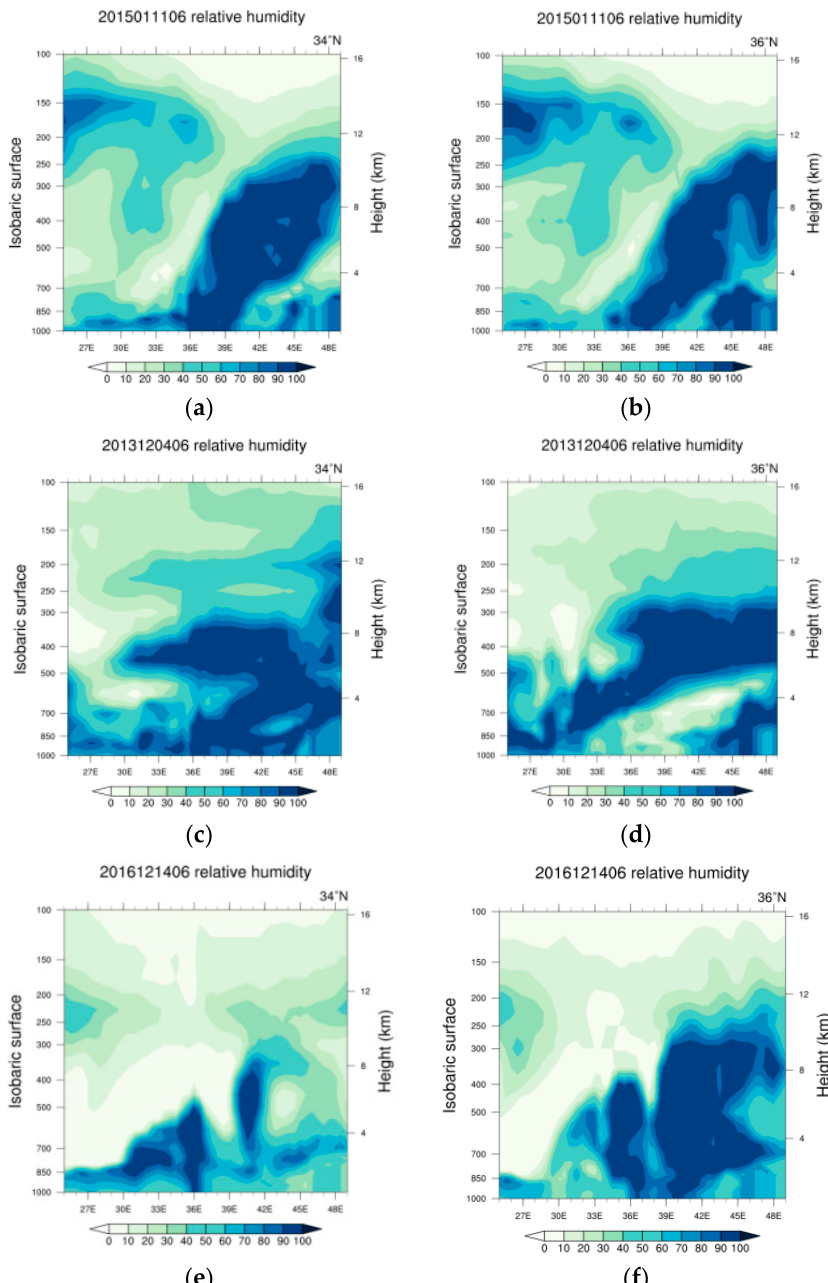
Figure 6. Vertical cross-section of relative humidity (unit: %) along 36° N and 34° N on strong rainfall days: 20161214 (( a ) 34° N, ( b ) 36° N), 20131204 (( c ) 34° N, ( d ) 36° N), 20150111 (( e ) 34° N, ( f ) 36° N).